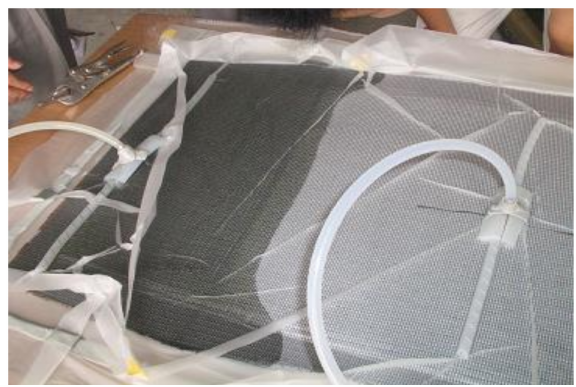
Figure 7. Manufacturing process of plate by resin